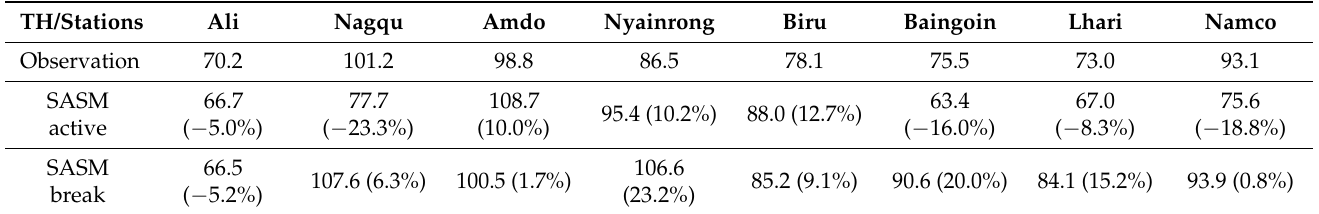
Table 4. Total heat flux (TH) (Wm − 2 ) over the 8 plateau stations, averaged for the observations and SASM active and break periods. The bracketed values denote the TH increasing (decreasing) percentage of the daily averaged value, in which the positive (negative) values mean increasing